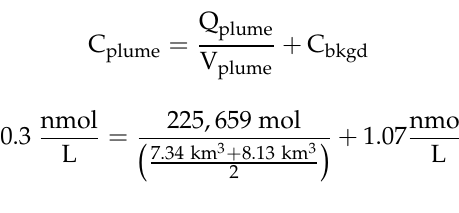
Calculation of the average element concentration in the plume using Equation (8) and data